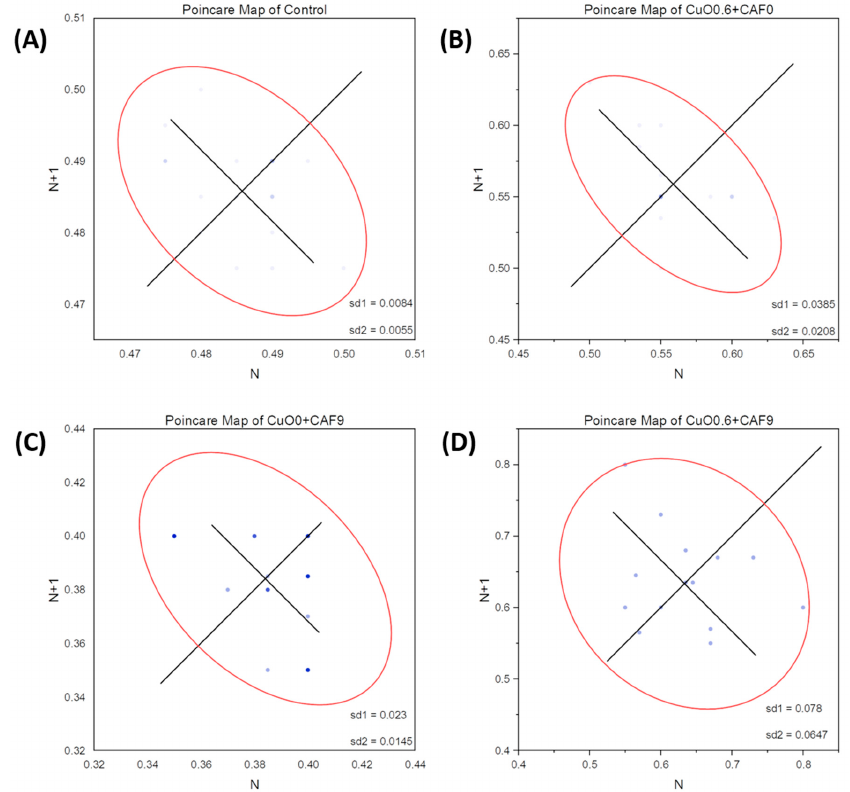
Figure A4. Poincare map of Zebrafish embryos after exposed to CuO nanoparticle and carbofuran. ( A ) Control, (B) CuO 0.6 mM + CAF 0 uM, ( C ) CuO 0 mM + CAF 9 uM, ( D ) CuO 0.6 mM + CAF 9 uM. (CuO = copper oxide nanoparticle (mM), CAR = carbofuran (µM)). Table A1. Previous study of synergistic effect of copper and pesticide on aquatic animal.